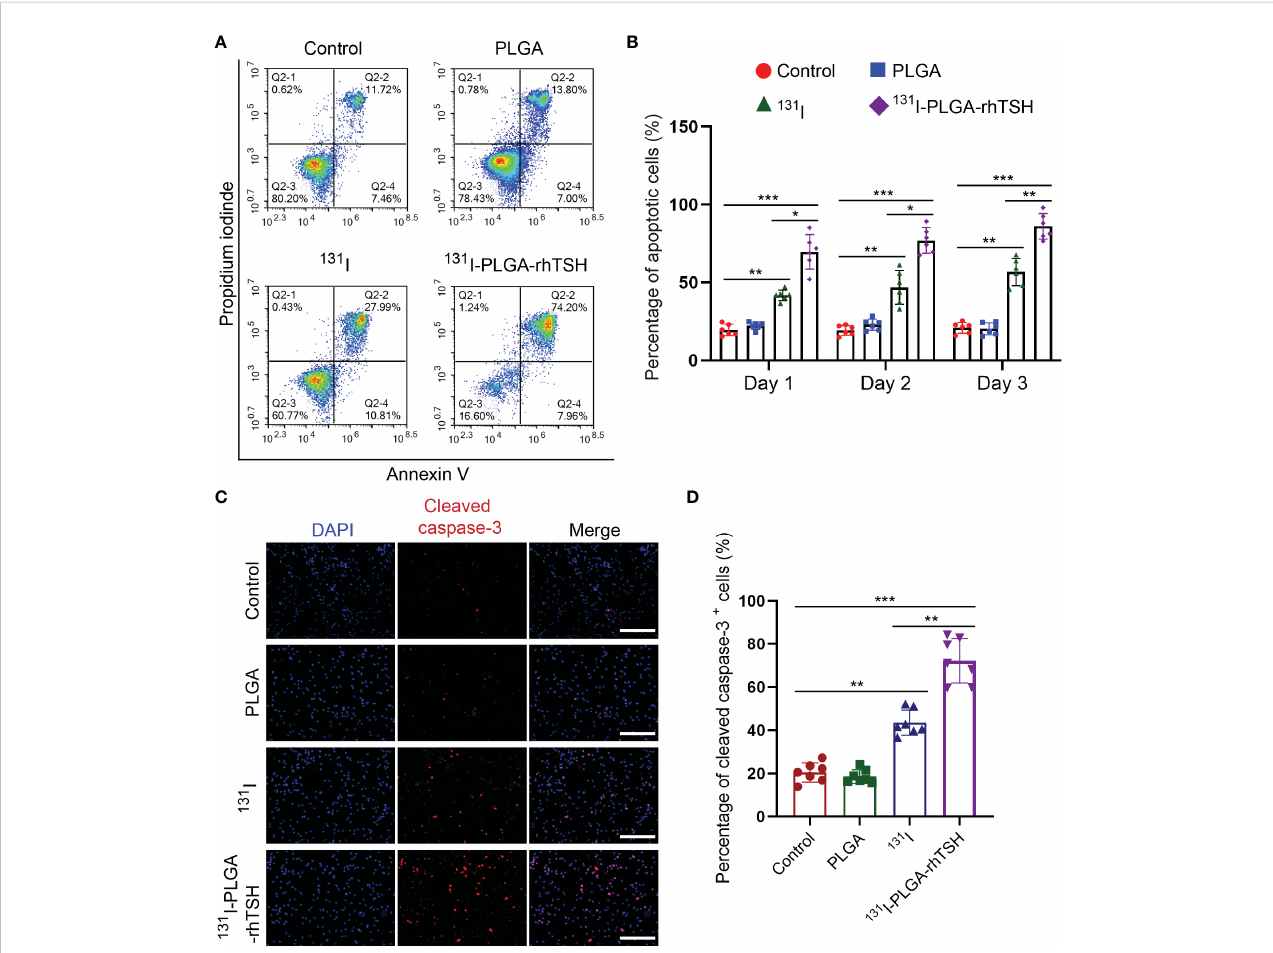
FIGURE 6 The application of 131 I-PLGA-rhTSH promoted the apoptosis of FTC-133 cells. (A) The fl ow cytometry images revealing the cell distribution in different groups on day 3. (B) A summarized bar graph showing the percentage of apoptotic cells from (A) . n = 6 per group, * p < 0.05, ** p < 0.01, *** p < 0.001; two-way ANOVA, followed by Tukey ’ s post hoc test. (C) The typical immunostaining images of cleaved caspase-3 in each group on day 3. The cell nuclei were counterstained with DAPI in blue. Scale bars: 50 m m. (D) A bar chart summarizing the percentage of cleaved caspase-3 + cells in each group. n = 7 per group; ** p < 0.01, *** p < 0.001; one-way ANOVA, followed by Tukey ’ s post hoc